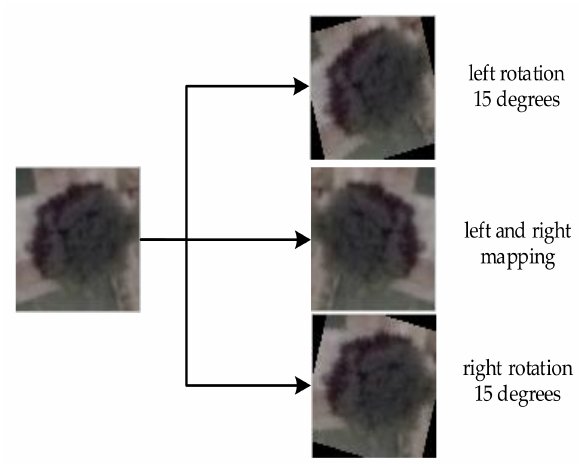
Figure 4. Sample-extension